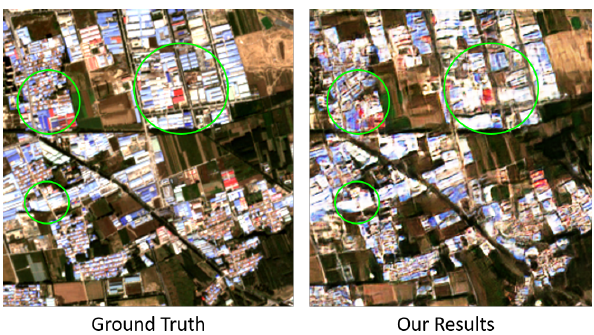
Figure 10. The comparison of ground truth and SR images in the town scene. The remote sensing image in the town area is full of various objects with different colors. The networks cannot distinguish one building with the others in the complicate